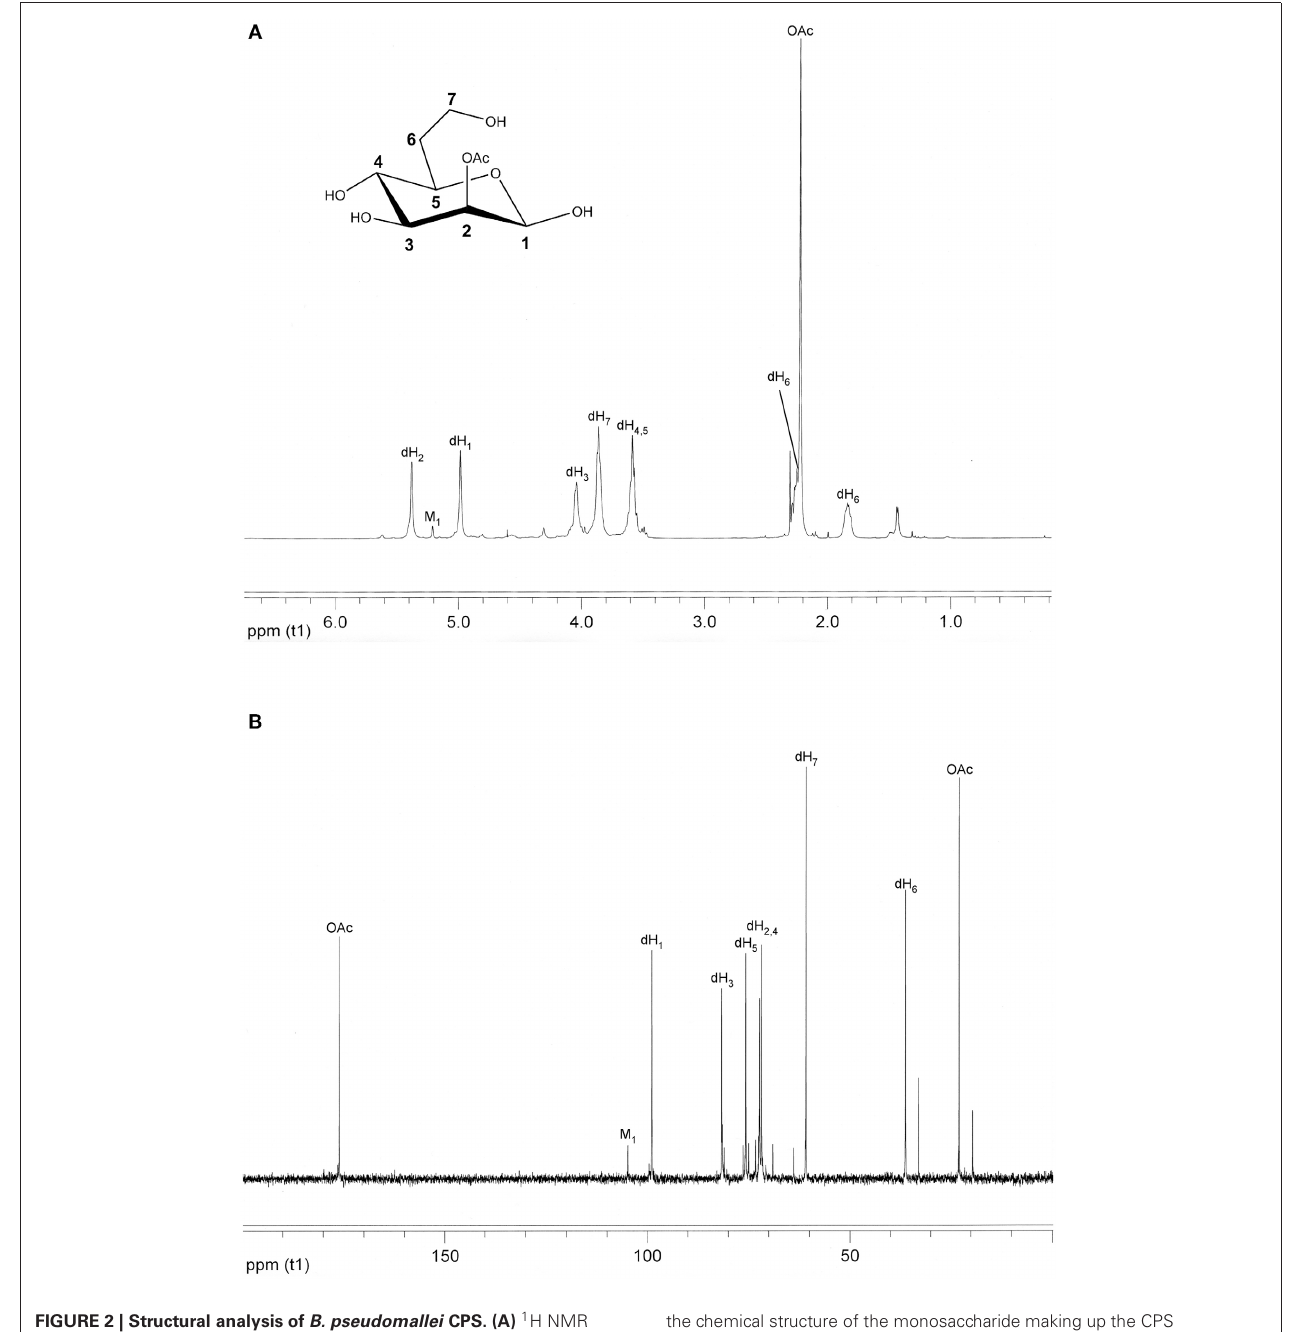
the chemical structure of the monosaccharide making up the CPS homopolymer is inset in panel A . dH, 6-deoxy-heptose;M, mannose; OAc, O